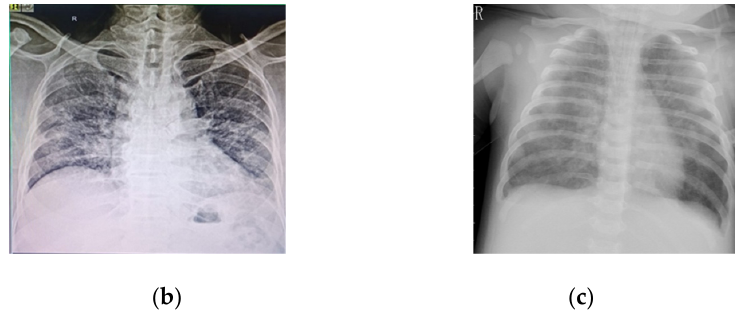
Figure 9. X-ray of ( a ) normal patient with no COVID-19 symptoms for pelvis surgery with negative PCR test; ( b ) is a patient with COVID-19 symptoms, positive PCR test on day 1 and 3; ( c ) is a pneumonia patient with negative PCR test on day 1, 3 and 5.